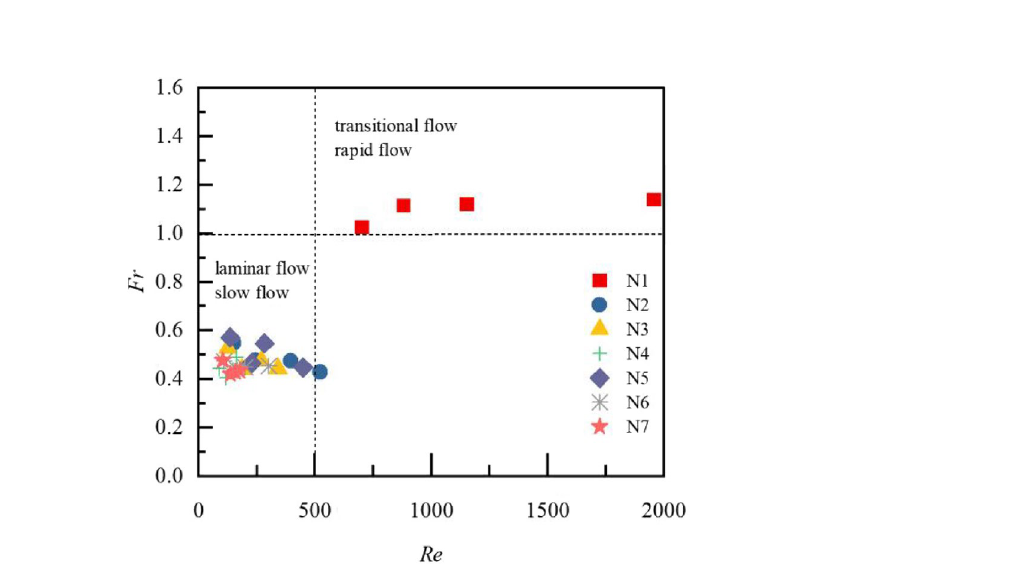
Figure 10. Overland flow regime zoning by litter covering. Re is the Reynolds number of the water flow; Fr is the Froude constant; T1 is slope 5°, rain intensity 60 mm·h −1 ; T2 is slope 10°, rain intensity 60 mm·h −1 ; T3